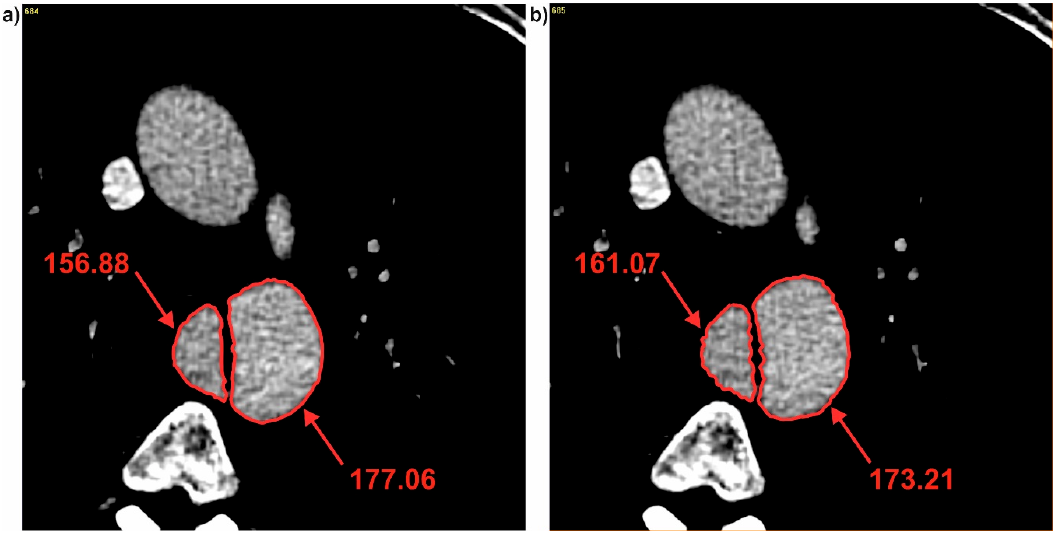
Figure 7. Brightness of true and false ducts for P1: ( a ) Cross-section number 11 and ( b ) cross-section number 12. Values of brightness were calculated in Pixels.